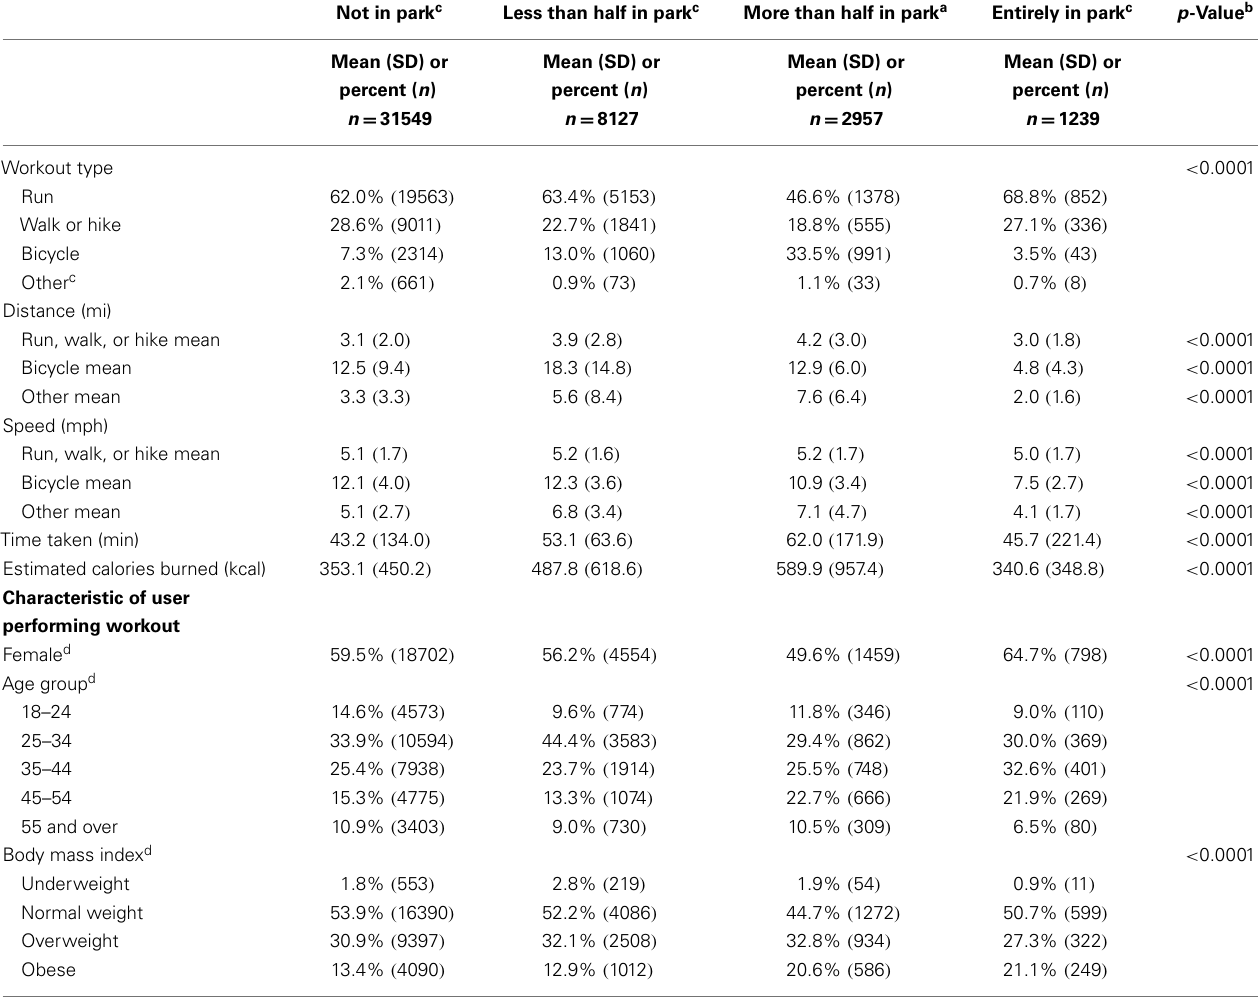
Table 2 | Characteristics ofWinston-Salem, NC,USA MapMyFitness workouts by percent of workout in parks (June 2006–September 2013). Not in park c Less than half in park c More than half in park a Entirely in park